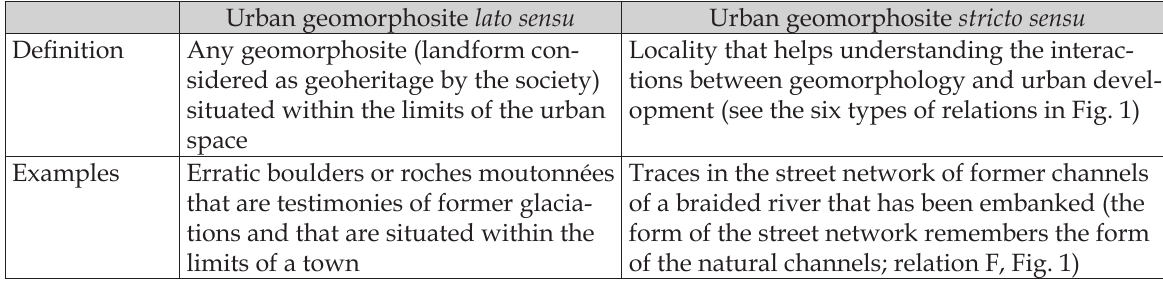
Table 1. Two categories of urban